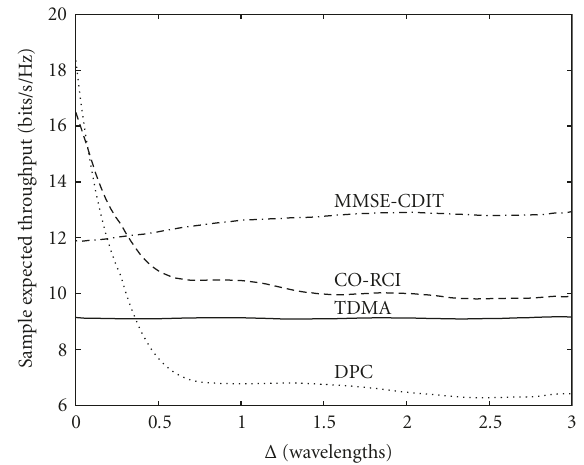
Figure 6: Sample expected throughput (SET) for N t = N r = 4, K = 5, and P = 10 in the measured channel with various transmit precoding